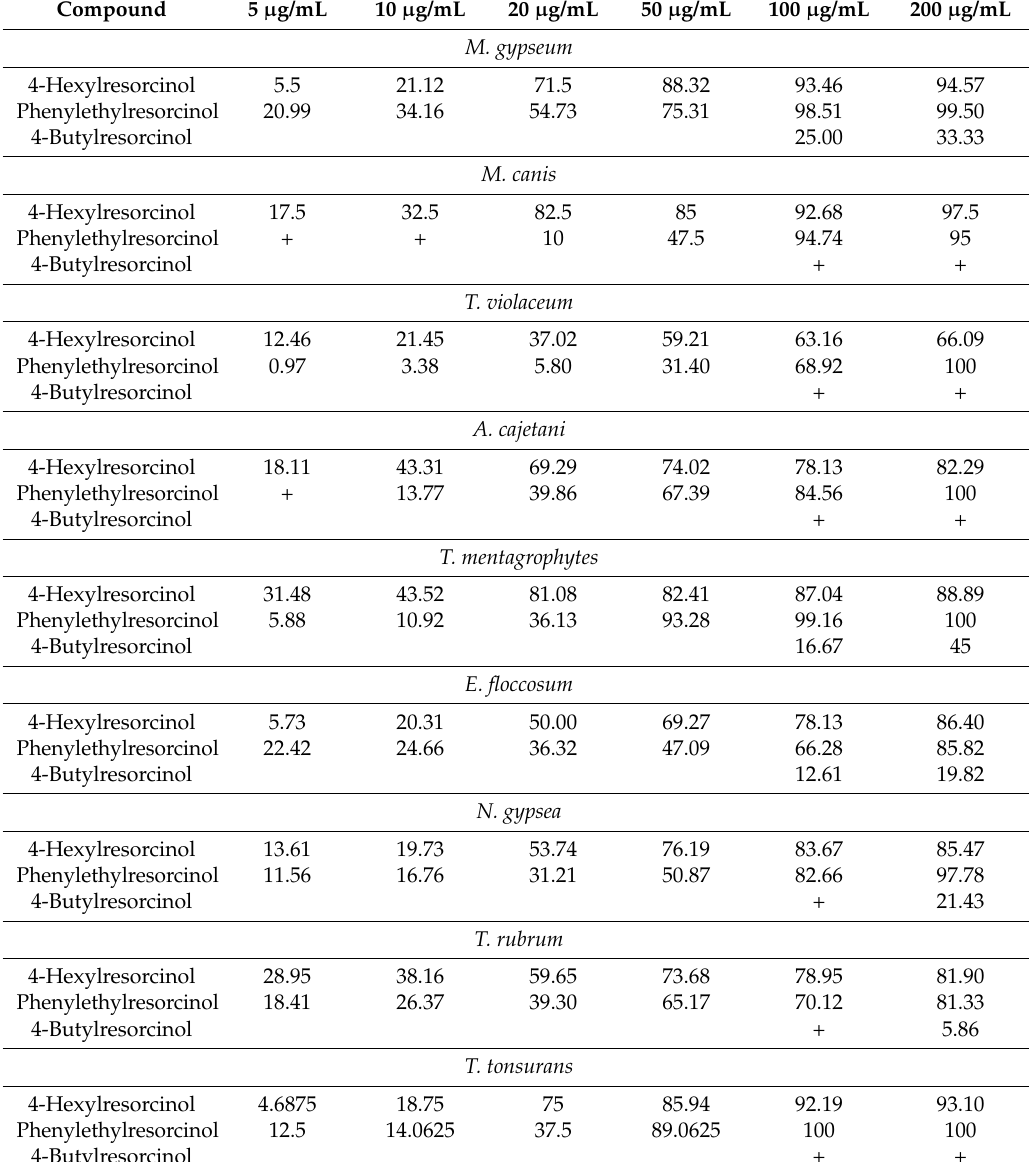
Table 1. Percentage of growth inhibition induced by the three tested resorcinol derivatives against nine dermatophytes after seven days of treatment at 5, 10, 20, 50, 100 and 200 µ g/mL. Each value is the mean of three measurements (all standard deviation values, not reported, were within